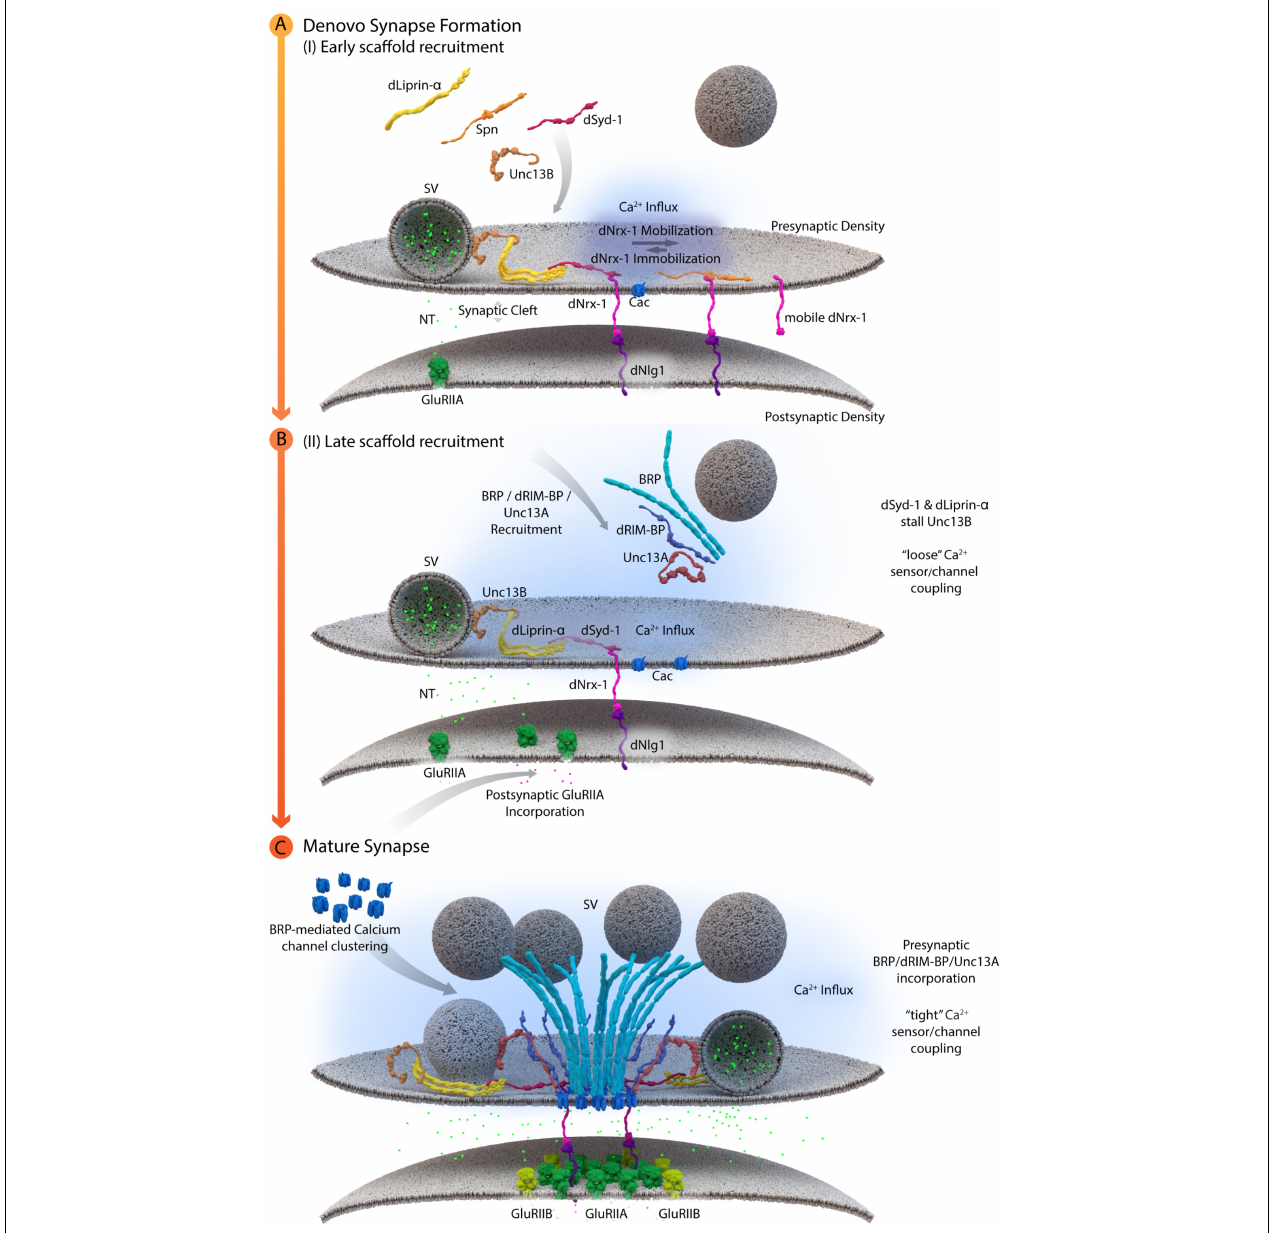
FIGURE 3 | A schematic depicting AZ assembly at Drosophila NMJs. (A) Depicts a schematic of the early AZ scaffold recruitment and assembly. Here, Spn (Spinophilin) acts antagonistically to dSyd-1 ( Drosophila Syd-1). Immobile dNrx-1 ( Drosophila Neurexin-1) molecules get stabilized at the presynaptic membrane by an interaction with the PDZ domain of dSyd-1. Once dNrx-1 is immobilized at the presynaptic membrane, it forms a bridge with its postsynaptic partner dNlg1 ( Drosophila Neuroligin1). In this way, trans-synaptic contact can also initiate pre- and postsynaptic scaffold assembly. Spn competes with dSyd-1 to bind dNrx-1, with its PDZ domain, thus reducing the amount of dNrx-1 available for dSyd-1 binding. This mechanism helps control the seeding and ultimately the number of AZs at a presynaptic bouton. In addition, dLiprin α also binds to dSyd-1 and together these proteins are known to recruit Unc13B to nascent synaptic sites. Unc13B mediated loose coupling of SVs, facilitates SV-fusion and thus NT (neurotransmitter) release into the synaptic cleft. (B) Illustrates a schematic of the late AZ scaffold assembly process. Once a nascent site is established, incorporation of postsynaptic GluRIIA (Glutamate receptor type IIA) on the postsynaptic scaffold is observed, while BRP (Bruchpilot); dRIM-BP ( Drosophila RIM-binding protein), and Unc13A proteins are recruited in a second wave of AZ scaffold assembly and center themselves at VGCC localizations. (C) Illustrates the AZ scaffold maturation process at a developing AZ. A stable AZ scaffold forms with BRP and dRIM-BP centered on the VGCCs; here represented by Cac ( Drosophila Cacophony). Pre-existing dLiprin α and Unc13B are pushed towards the extremities of the AZ scaffold. The N-terminus of dSyd-1 localizes close to the C-terminal region of BRP. In addition, dSyd-1 still maintains its binding partners the dNrx-1 and dLiprin α , thus tethering the early scaffold to the late AZ scaffold structure. BRP mediated VGCC clustering occurs at the presynaptic terminus, while at the postsynapse the incorporation of GluRIIB (Glutamate receptor type IIB) receptors, predominantly occurs outside the GluRIIA receptor field. Unc13A localizes SVs for tight coupling at approximate distances around 70 nm from the center of the